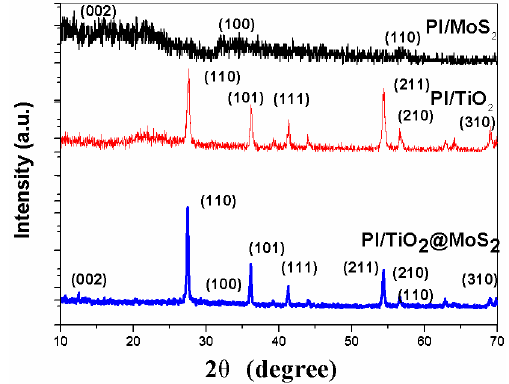
Figure 4. XRD pattern of the as-prepared PI/MoS 2 , PI/TiO 2 and PI/TiO 2 @ MoS 2 . 2θ .